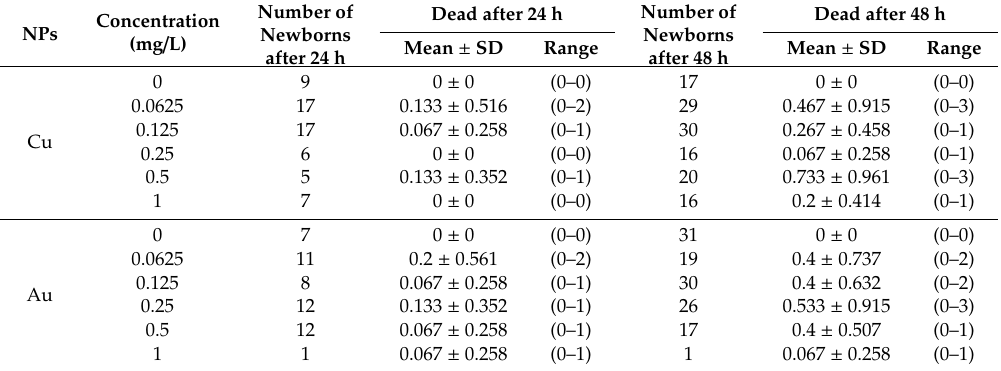
Table 2. E ff ects of di ff erent concentrations of NPs solution on survival of newborn Daphnia pulex.